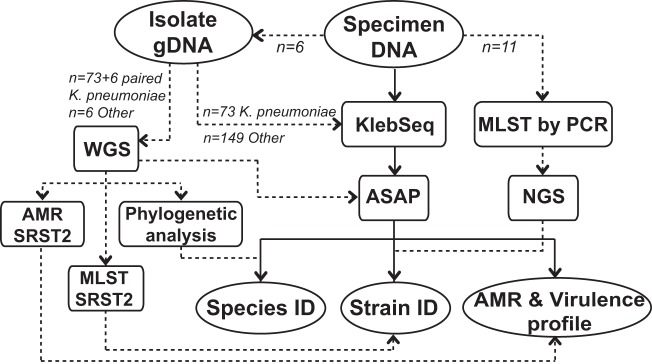
Workflow of the validation of KlebSeq. Dotted lines are methods used to confirm results from the workflow in solid lines (KlebSeq of specimen DNA). Strain identification validation was performed for 73 isolates plus 6 isolates that were cultured from KlebSeq-tested specimens (Tables 2 and 3). MLST PCR and sequencing were performed with 11 specimen DNA samples (Table 3). AMR gene detection validation is described in the text. The overall specimen KlebSeq results are in Table S4 in the supplemental material. NGS, next-generation sequencing.